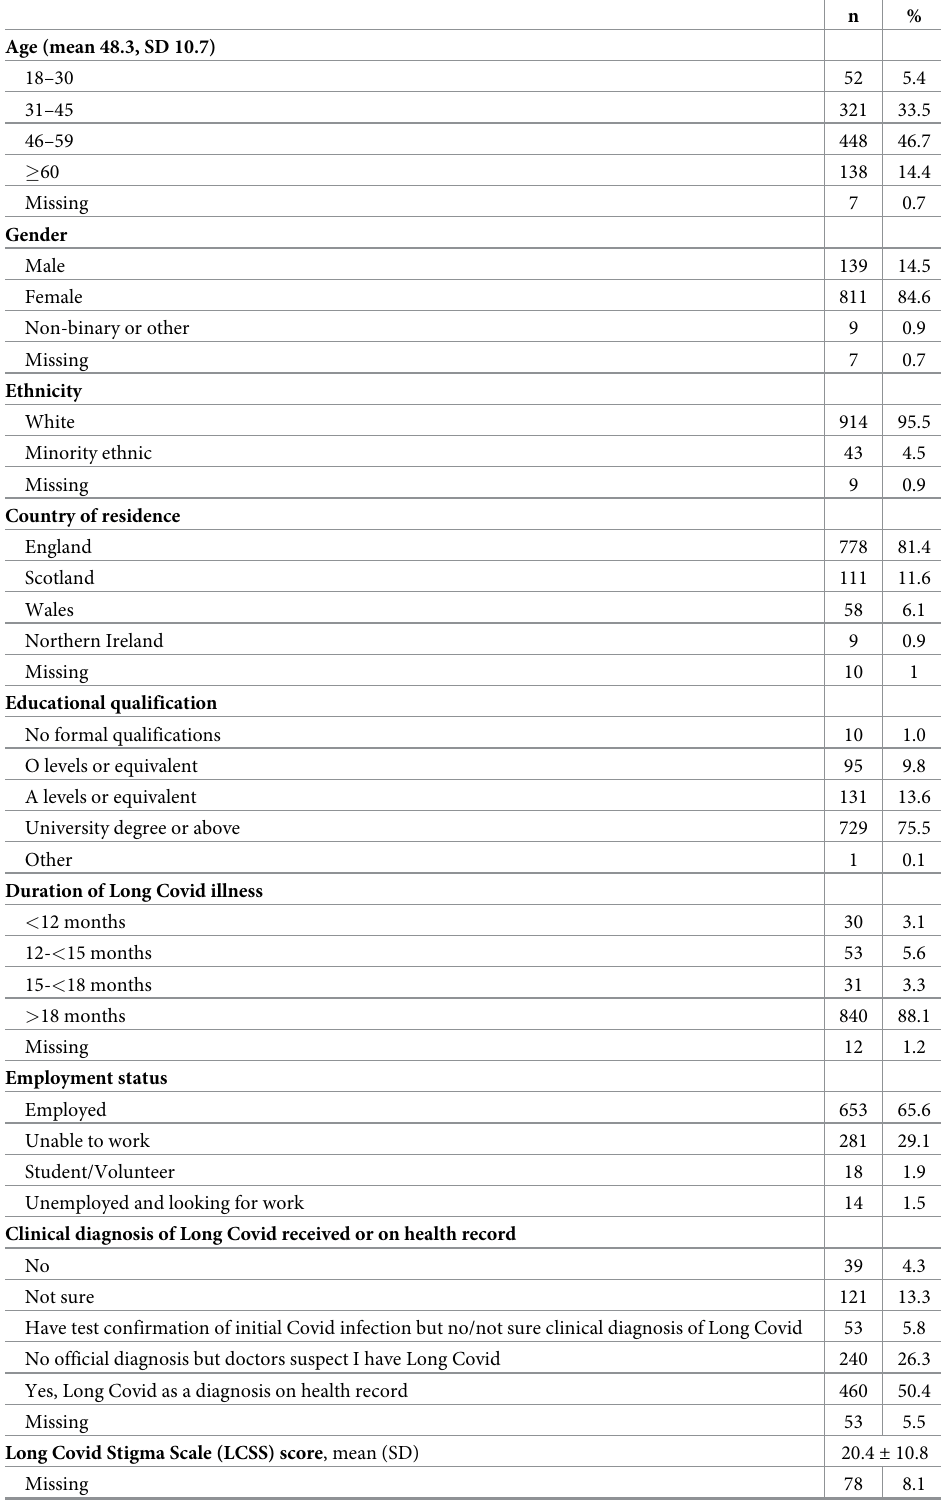
Table 1. UK sample characteristics (n =